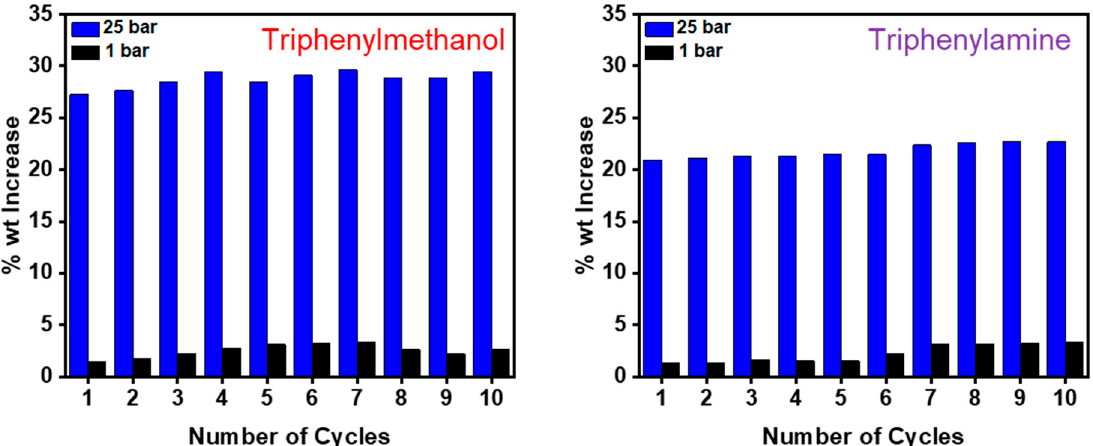
Figure 6. Recyclability studies for triphenylmethanol (left) and triphenylamine (right) networks during 10 adsorb/desorb cycles of CO 2 at 25 bar and 40 °C.